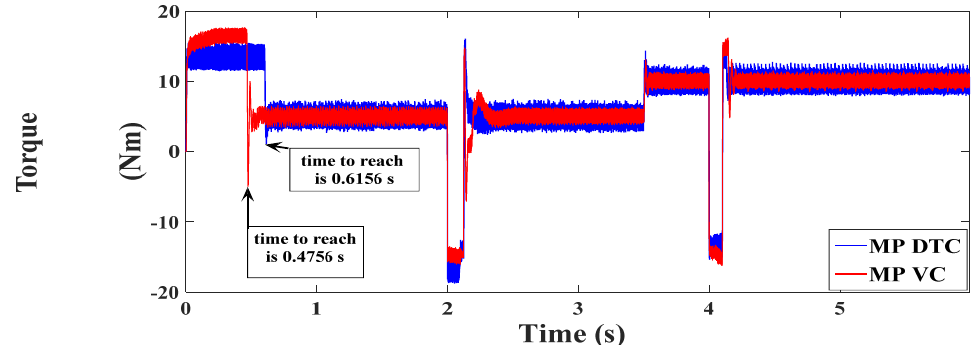
Figure 25. Torque profiles for the two control algorithms (Nm).